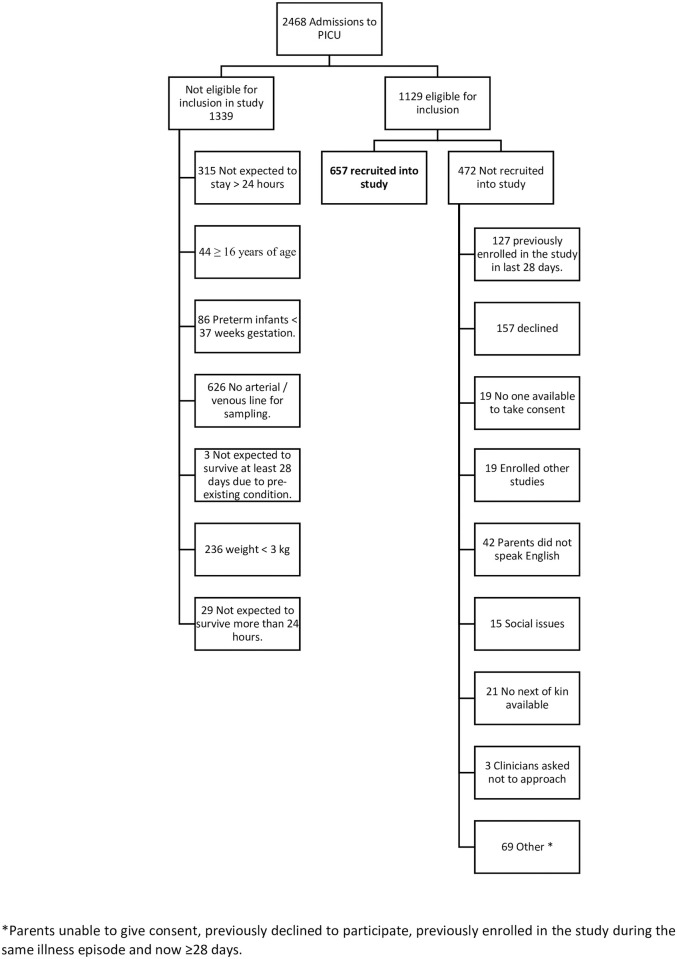
Patient flow diagram.*Parents unable to give consent, previously declined to participate, previously enrolled in the study during the same illness episode and now ≥28 days.